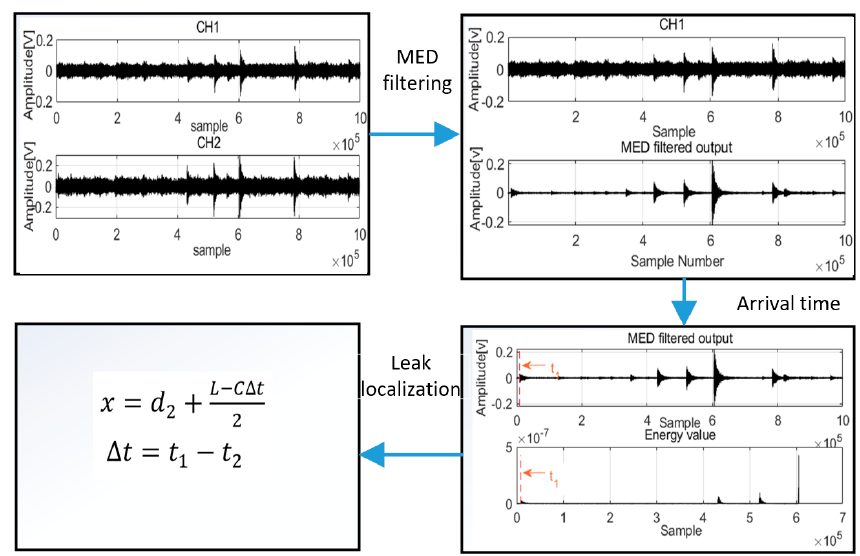
Figure 6. The process of the proposed method architecture.